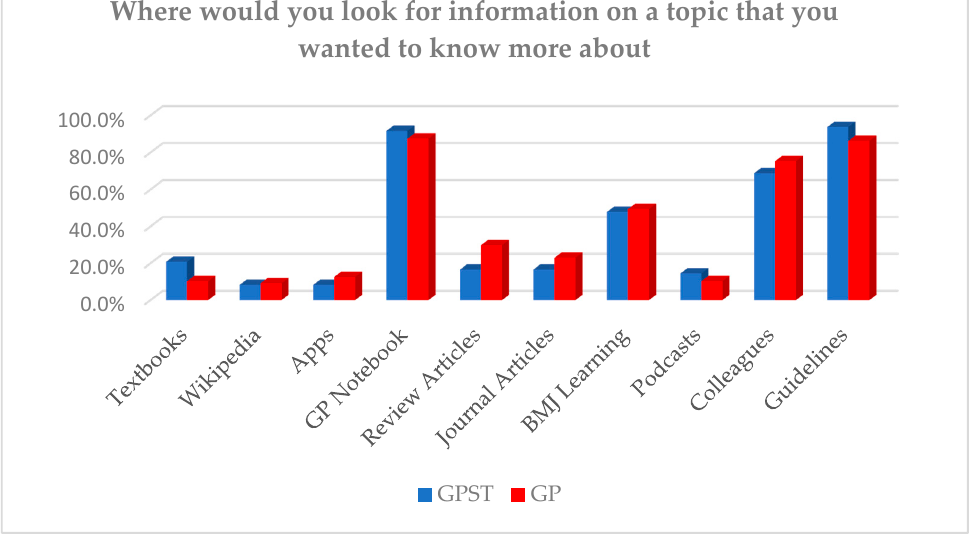
Figure 1. What resources do General Practitioner (GP) and GPSTs use for educational purposes (able to select multiple).